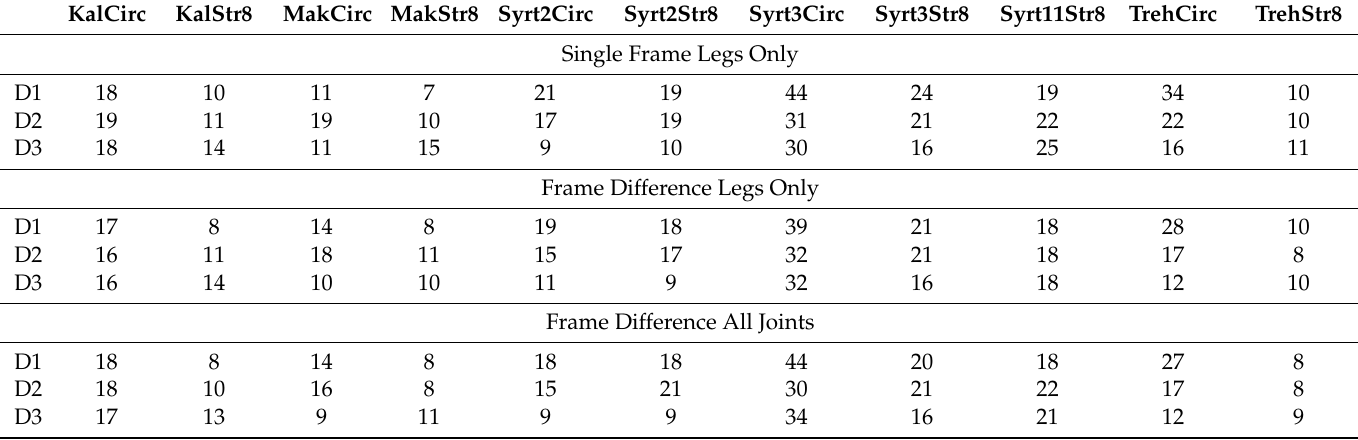
Table 1. Number of representative frames per dance when using TC-OPTICS sampler. This example treats straight and circular trajectories as different